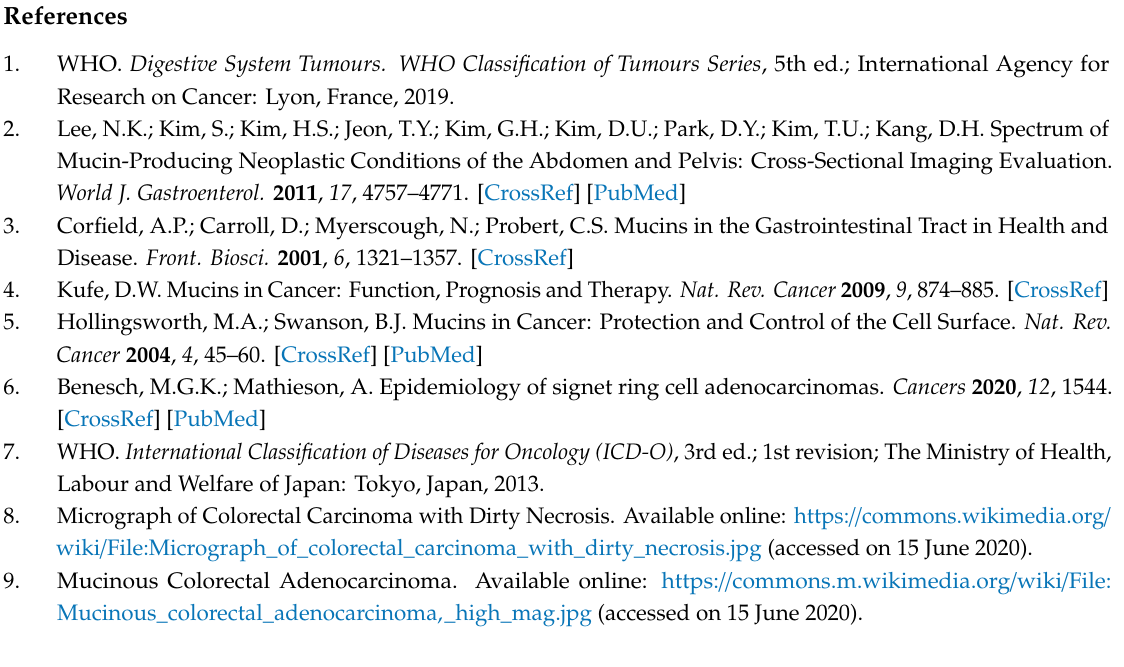
Table S1: Baseline demographics and clinical characteristics by histology for gynecological cancers, Table S2: Derived univariate and multivariable Cox-proportional hazard ratios (HR) of mortality for gynecological cancers, Table S3: Exclusion criteria and counts of all cases and mucinous cases, Table S4. Count of all cases and mucinous cases by SEER cancer registry for all included cases, Table S5: Variables in analysis. Table S6: Breakdown of mucinous cases in SEER (1975–2016), both analyzed and not